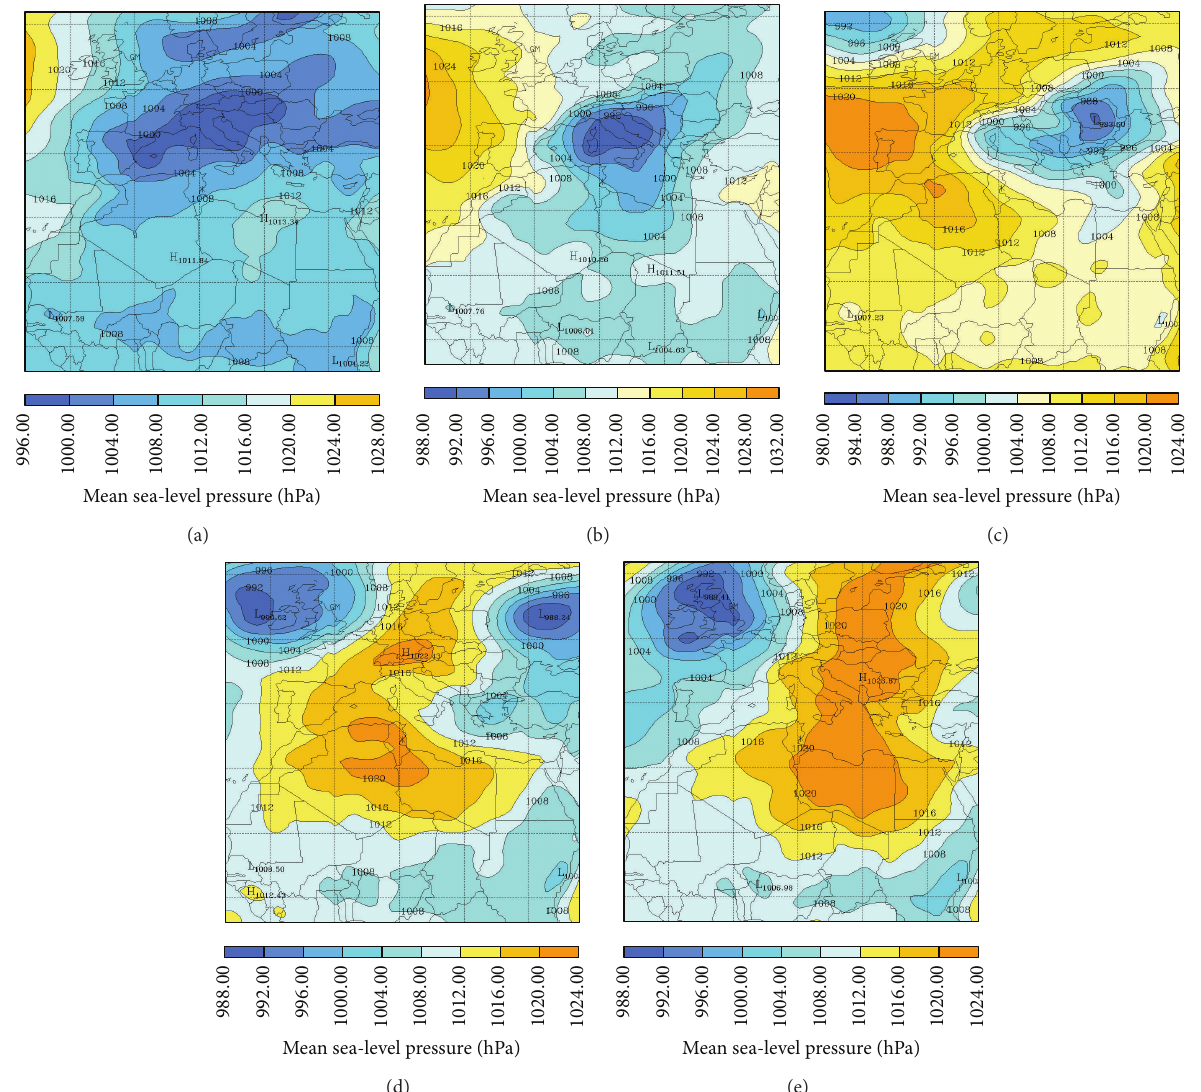
Figure 10: Surface synoptic maps over Sfax on (a) 13/03/2013, (b) 14/03/2013, (c) 15/03/2013, (d) 16/03/2013, and (e)